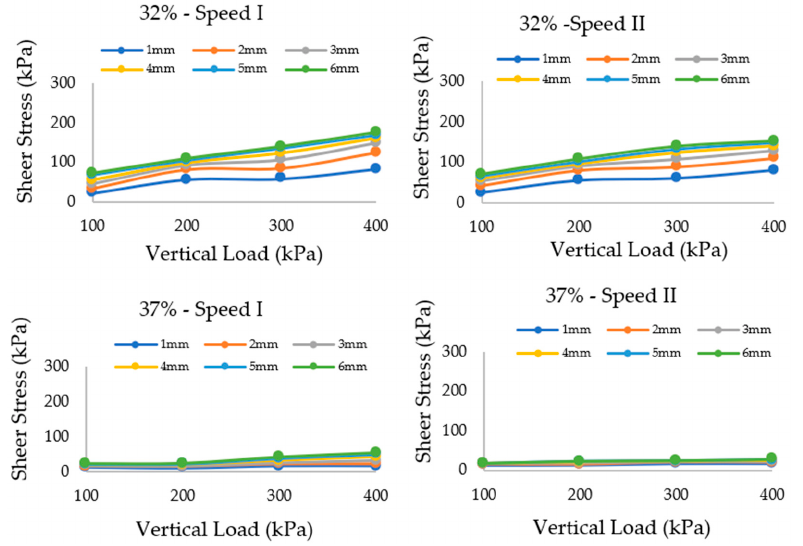
Figure 8. The relationship of shear strength corresponding to different shear displacements under different normal loads and shear speeds.